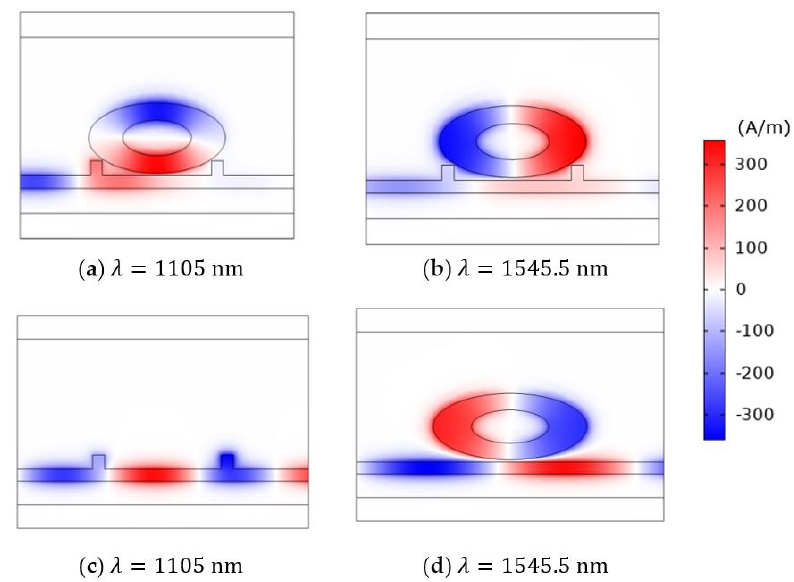
Figure 3. The Hz field distribution of the resonant dip: ( a ) the whole system at λ = 1105 nm; ( b ) the whole system at λ = 1545.5 nm; ( c ) without the elliptical ring resonator at λ = 1105 nm; ( d ) without two rectangular stubs at λ = 1105 nm.